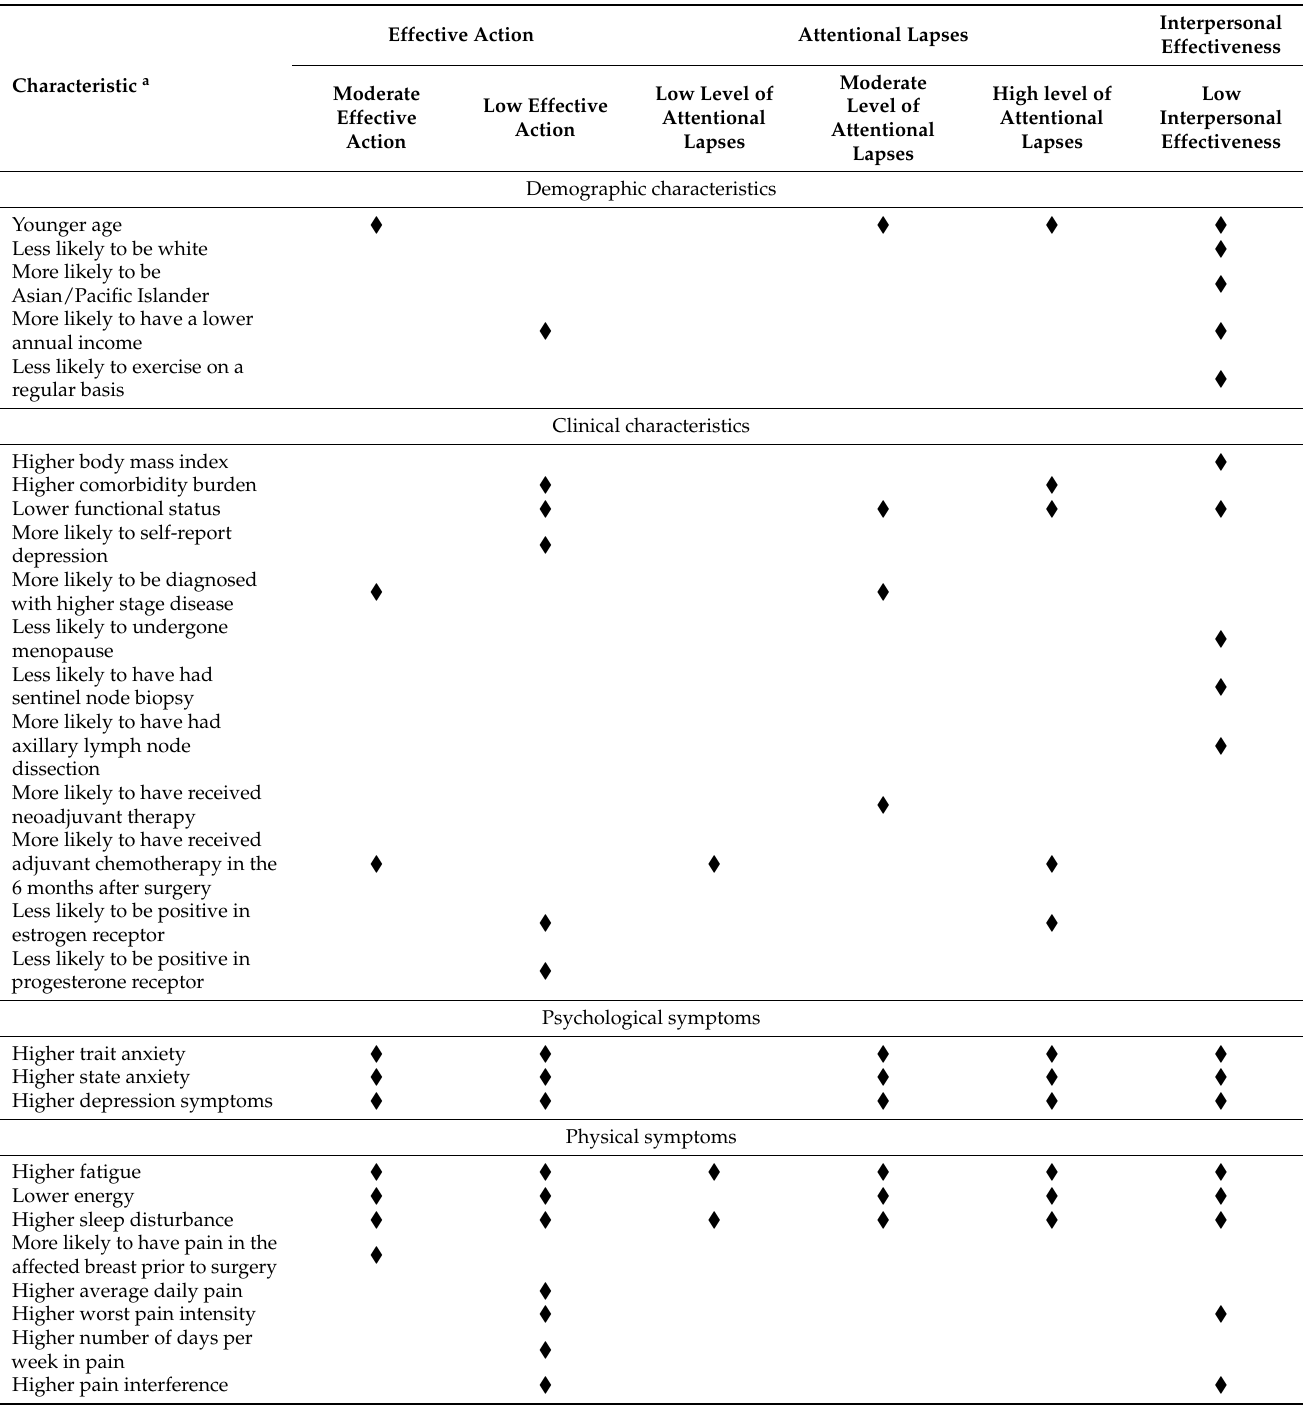
Table 7. Characteristics Associated with Membership Among the Effective Action, Attentional Lapses, and Interpersonal Effectiveness